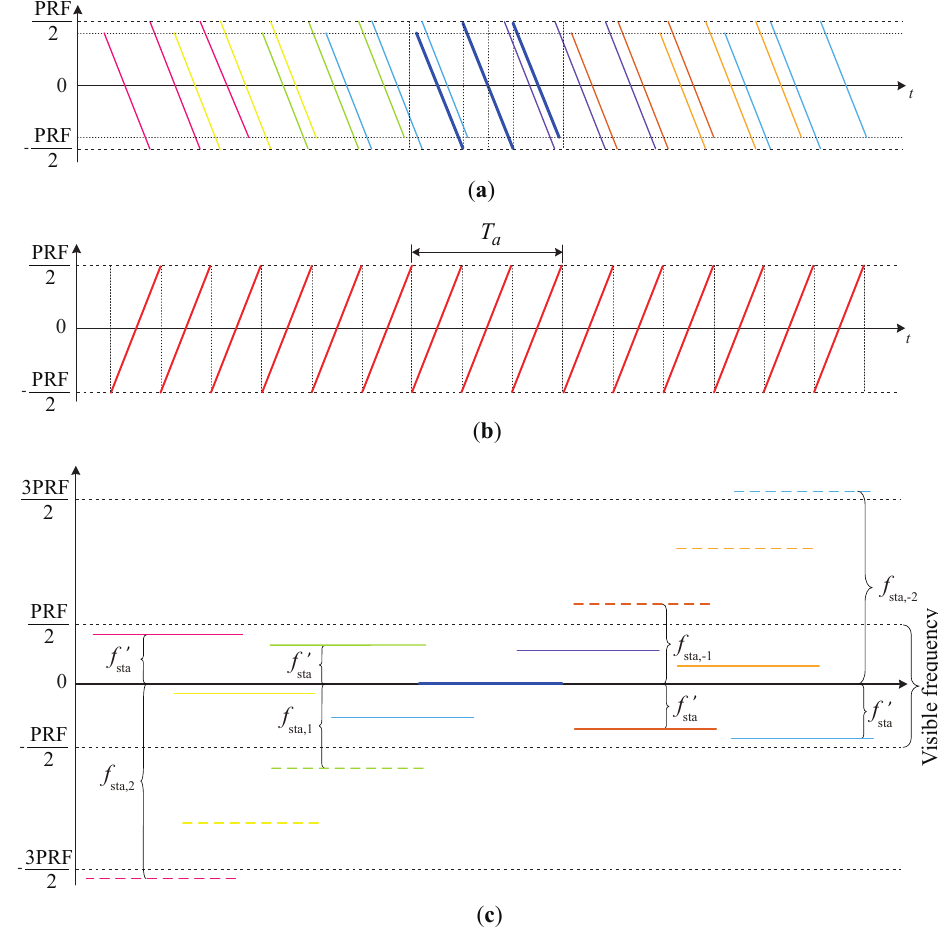
Figure 3. Frequency and time characteristics of multiple stationary targets in a whole illumination time, before and after the deramp processing in a multichannel HRWS SAR system, ( a ) the signals of 9 targets before the deramping, ( b ) the deramp function, ( c ) the aliased signals of 9 targets after the